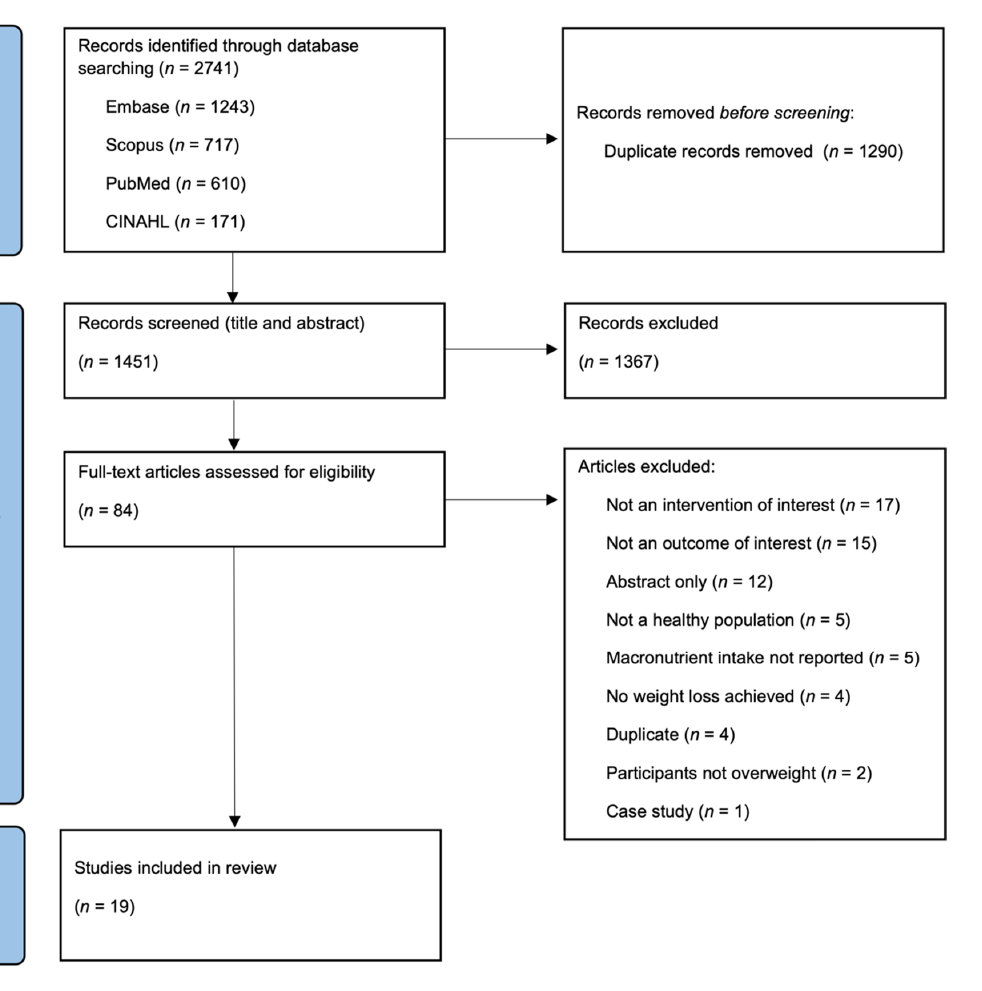
Figure 1. Flow diagram for study selection .